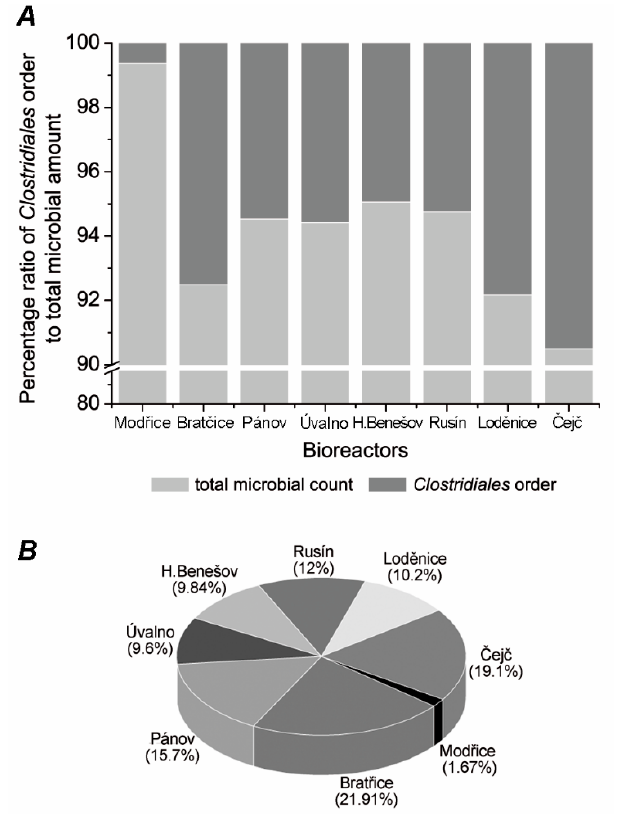
Figure 1. Ratio of Clostridiales representative composition: ratio between Clostridiales order and total microbial amount ( A ); pie-graph indicating portions of each biogas plant to Clostridiales order ratio ( B ).